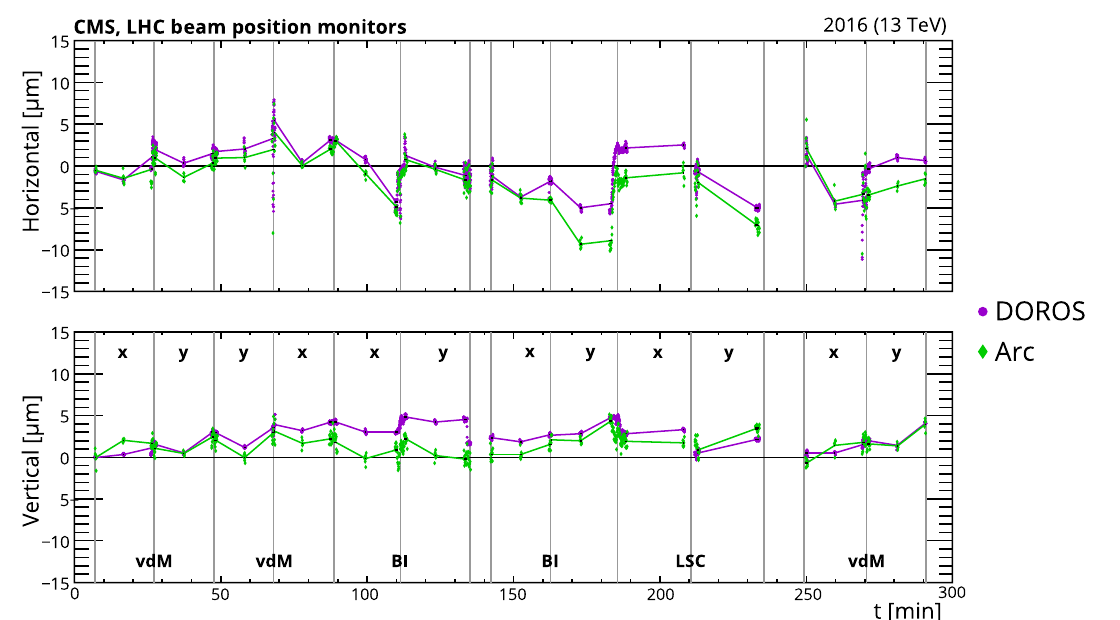
Fig. 7 Effectoforbitdriftinthehorizontal(upper)andvertical(lower) beam-separation directions during fill 4954. The dots correspond to the beam positions measured by the DOROS or LHC arc BPMs in µ m at times when the beams nominally collide head-on and in three periods per scan (before, during, and after) represented by the vertical lines. Fig. 8 The beam-separation residuals in y during all scans in fills 4266 (upper) and 4954 (lower) are shown on the left. The dots correspond to the difference (in terms of beam separation in µ m) between the corrected beam positions measured by the DOROS BPMs and the beam separation provided by LHC magnets (“nominal”). The error bars denote the standard deviation in the measurements. The figures on the right show the residual position differences per beam between the DOROS BPMs and LHC positions for the first vdM scans in y in fills 4266 (upper) and 4954